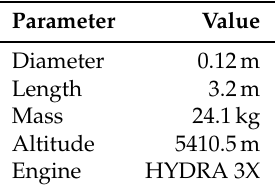
Figure 2. Design of the sounding rocket Faust. Table 1. The Faust rocket’s